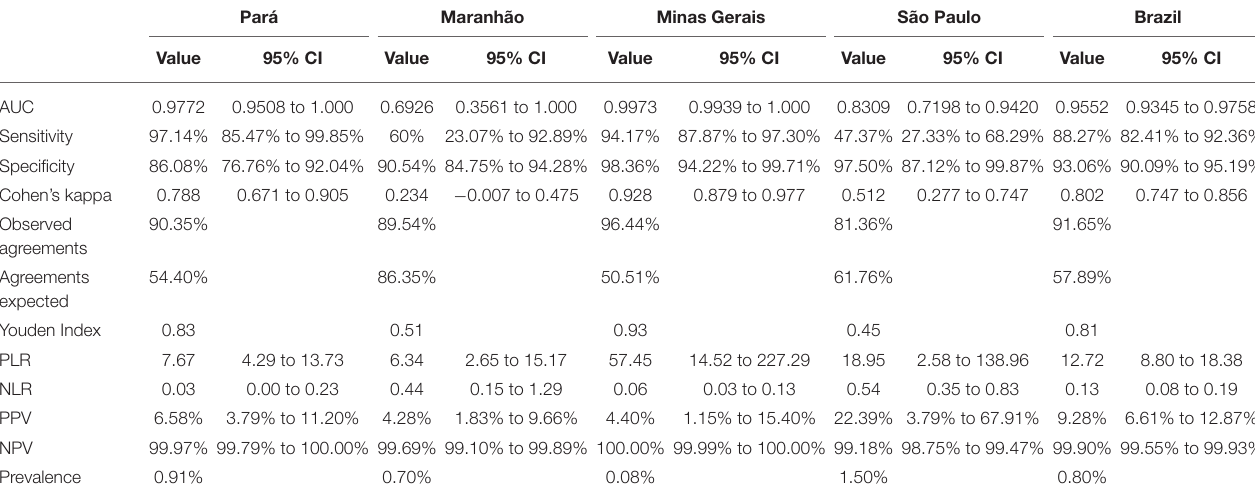
TABLE 2 | Statistical analysis of the ELISA multi-epitope recombinant’s performance by state and HTLV positive and negative samples. Pará